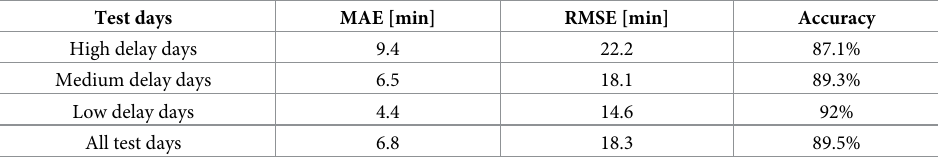
Table 3. The performance for three types of test days and all test days with different measurements.